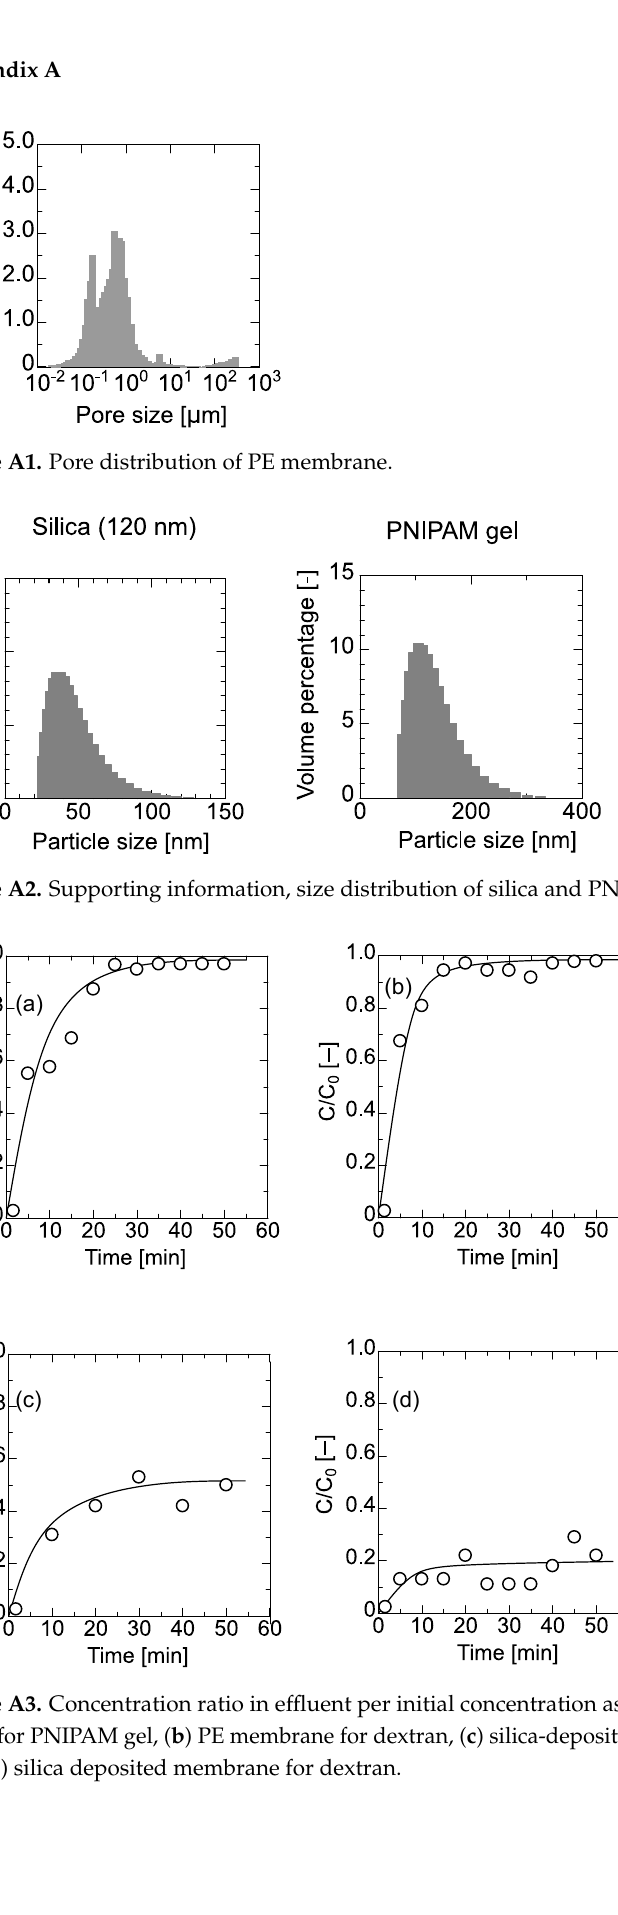
Figure A3. Concentration ratio in effluent per initial concentration as a filtration time. ( a ) PE mem- brane for PNIPAM gel, ( b ) PE membrane for dextran, ( c ) silica-deposited membrane for PNIPAM gel, and ( d ) silica deposited membrane for dextran.